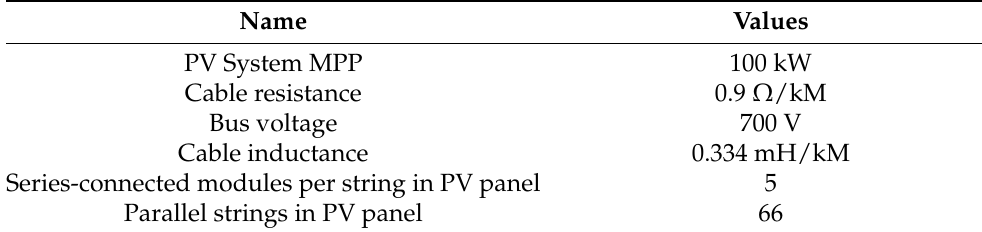
Table 1. DC Microgrid Configuration Parameters.